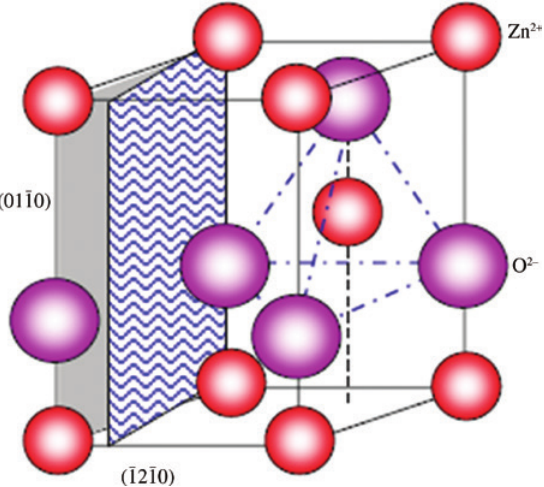
Figure 3: ZnO wurtzite structure showing the polarities (Reprinted with permission from Ref. [30], copyright 2004 by IOP